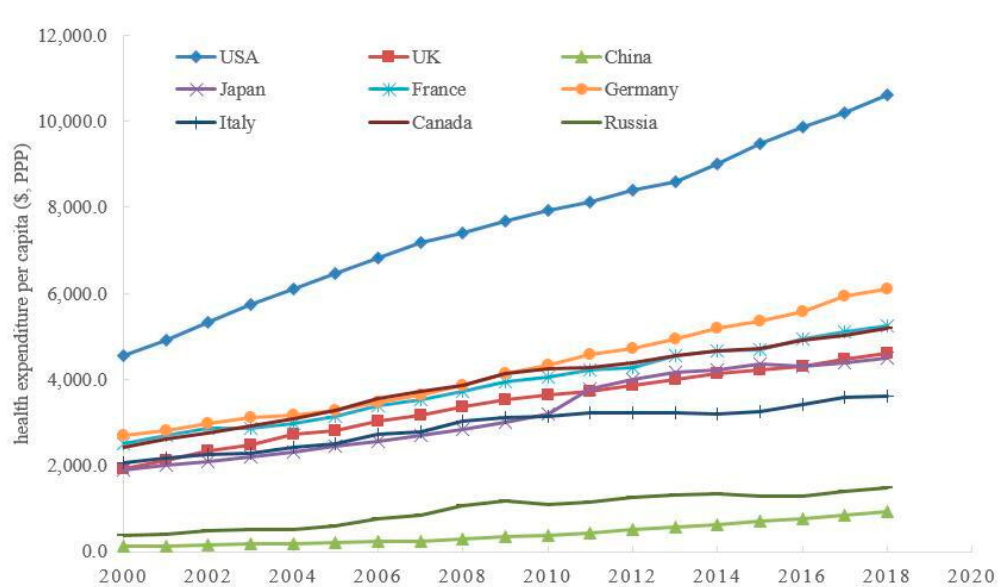
Figure 2. The trends of health expenditure per capita of selected countries. Source: https://data.worldbank.org/indicator/SH.XPD.CHEX.PP.CD, accessed on 22 October 2022.